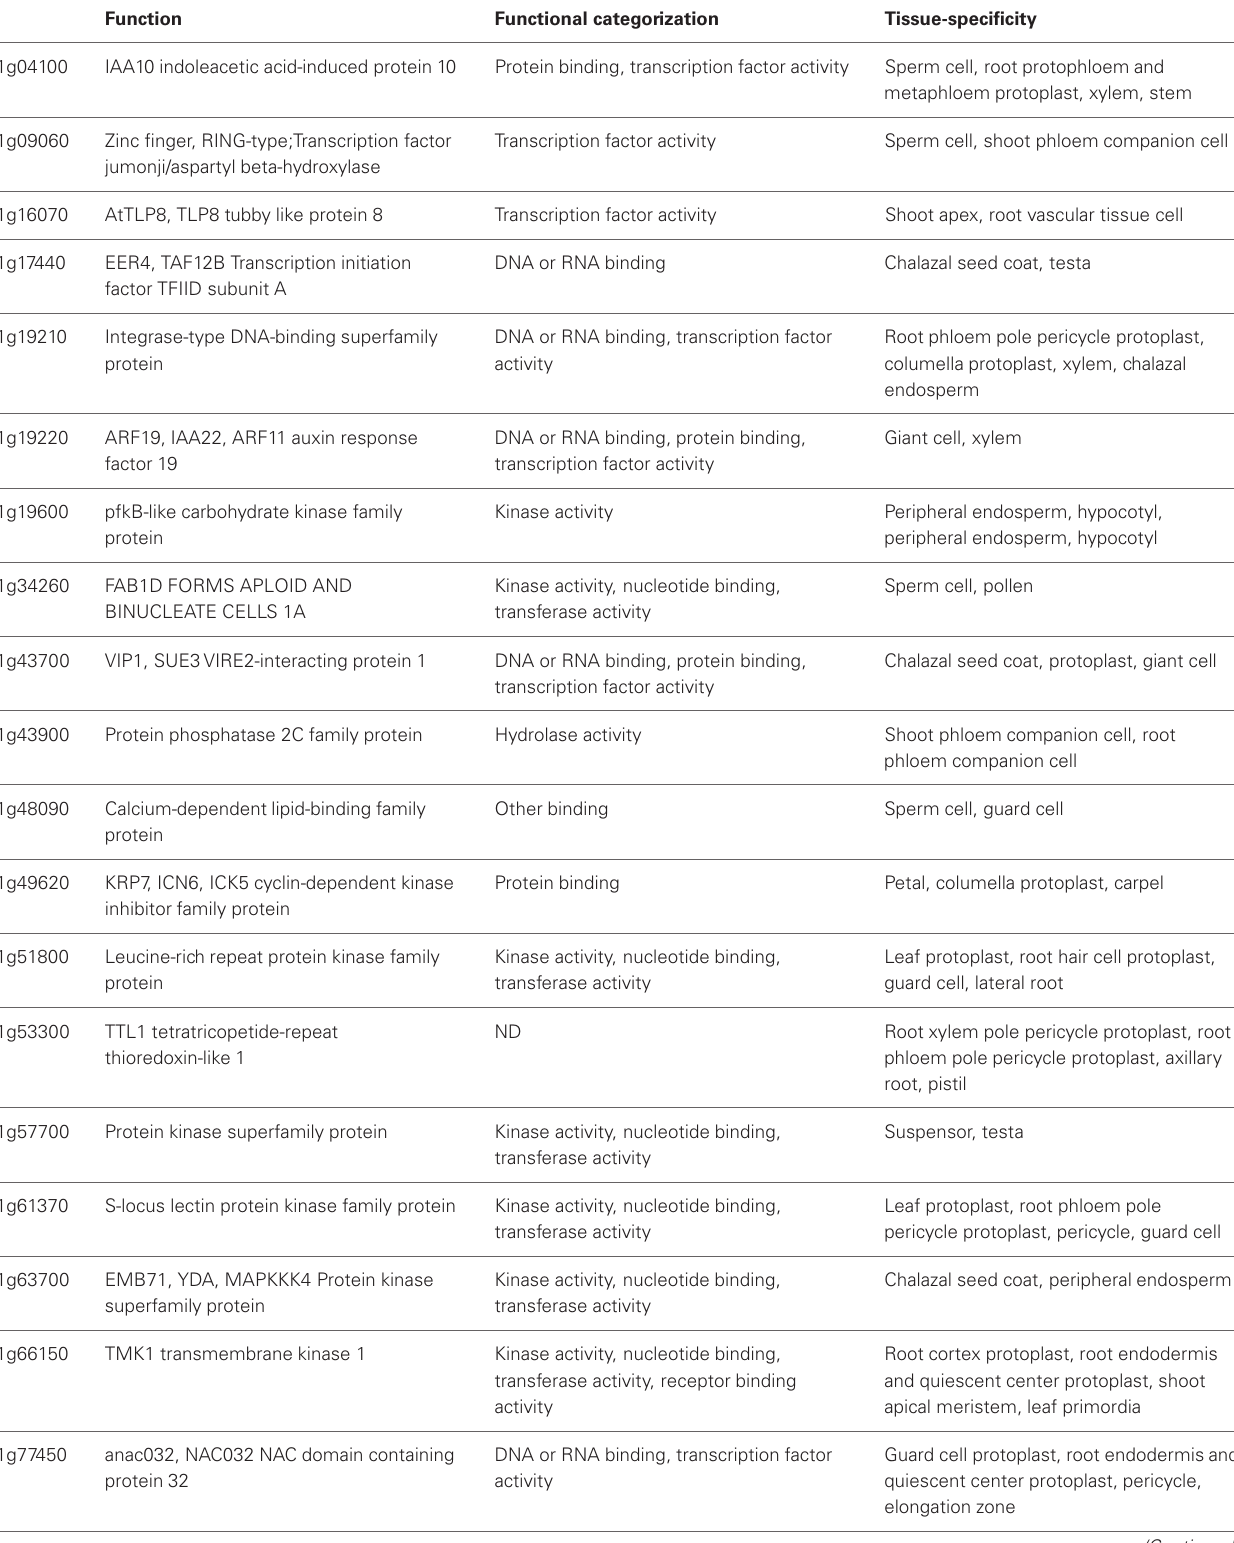
Table 1 | List of SETPs used for this